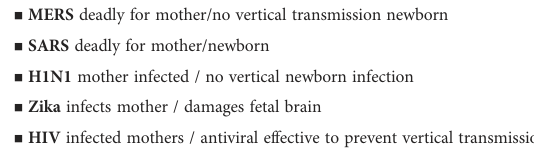
TABLE 4 Lessons from previous